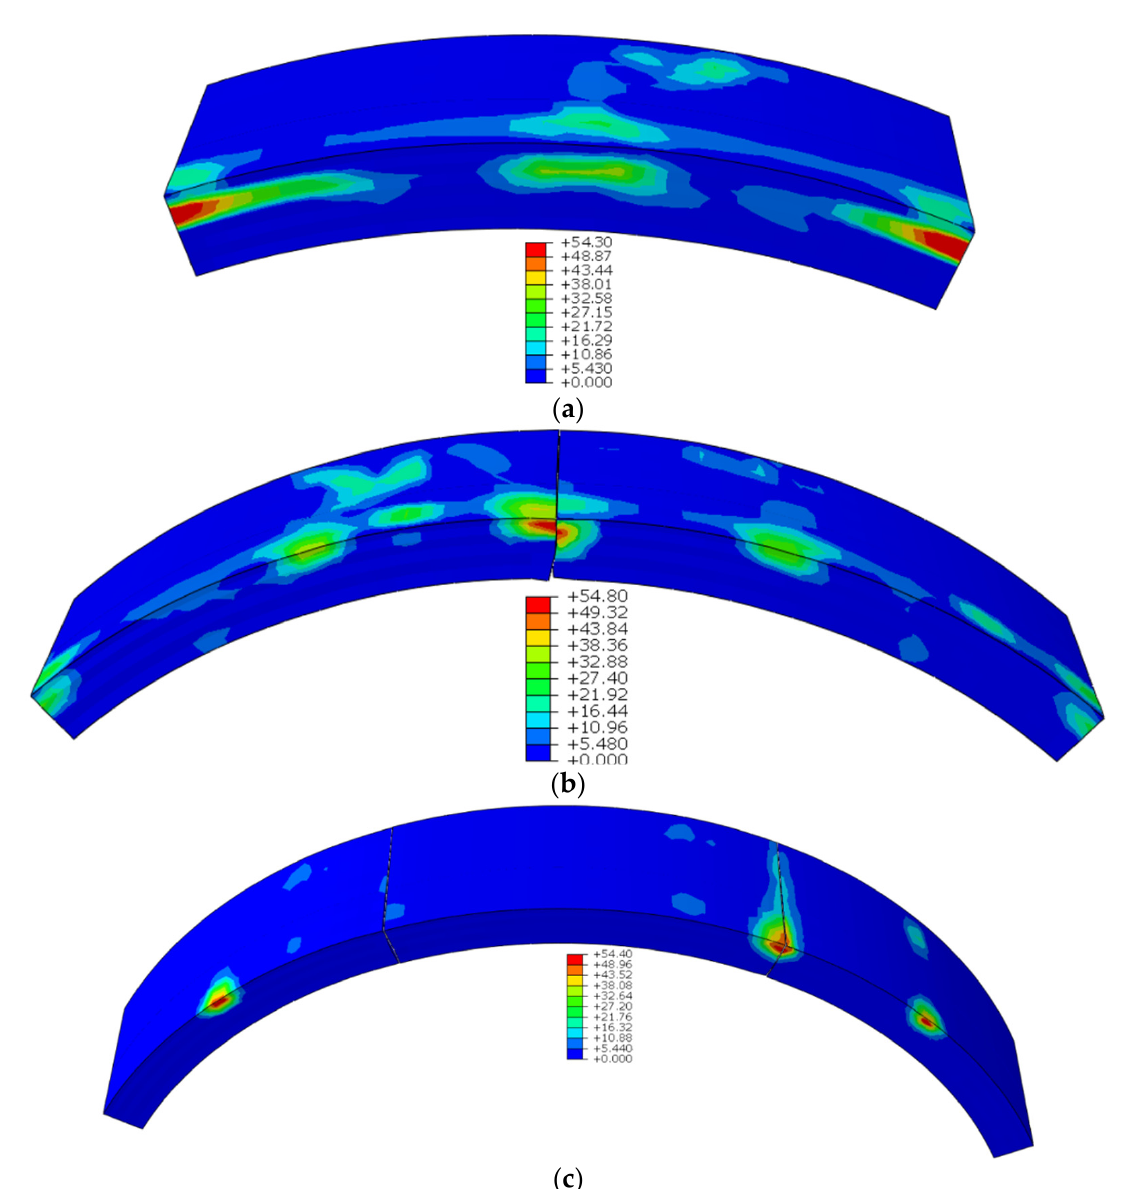
Figure 16. Damage to segment in the presence of outward deflection when the asymmetric error angle is 1.4°: ( a ) first segment assembly (%); ( b ) second segment assembly (%); ( c ) third segment assembly (%). (Take the segment at the bottom as an example.) Table 5. Damage to the segments.